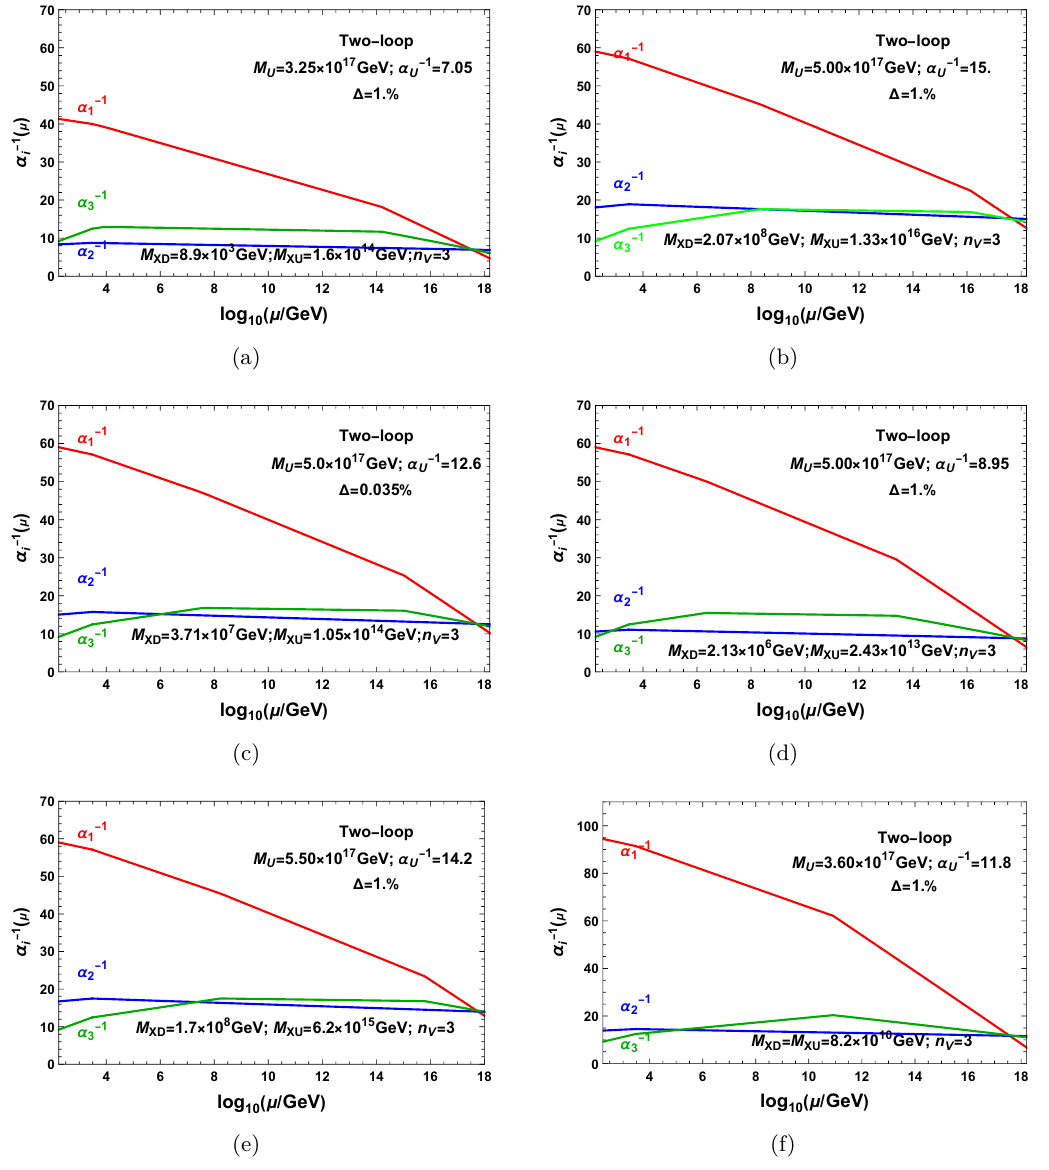
Figure 19 . Two-loop evolution of gauge couplings for the Model 18 (a), Model 19 (b), Model 20 (c), Model 21 (d), Model 22 (e) and Model 23 (f) with vector-like particles. The string-scale gauge coupling relation can be achieved by adding 3( XD + XD ) + 3( XU + XU ) .